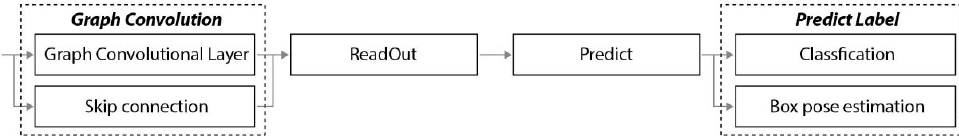
Figure 5. The flow of Convolutional Layer, Skip connection, ReadOut.